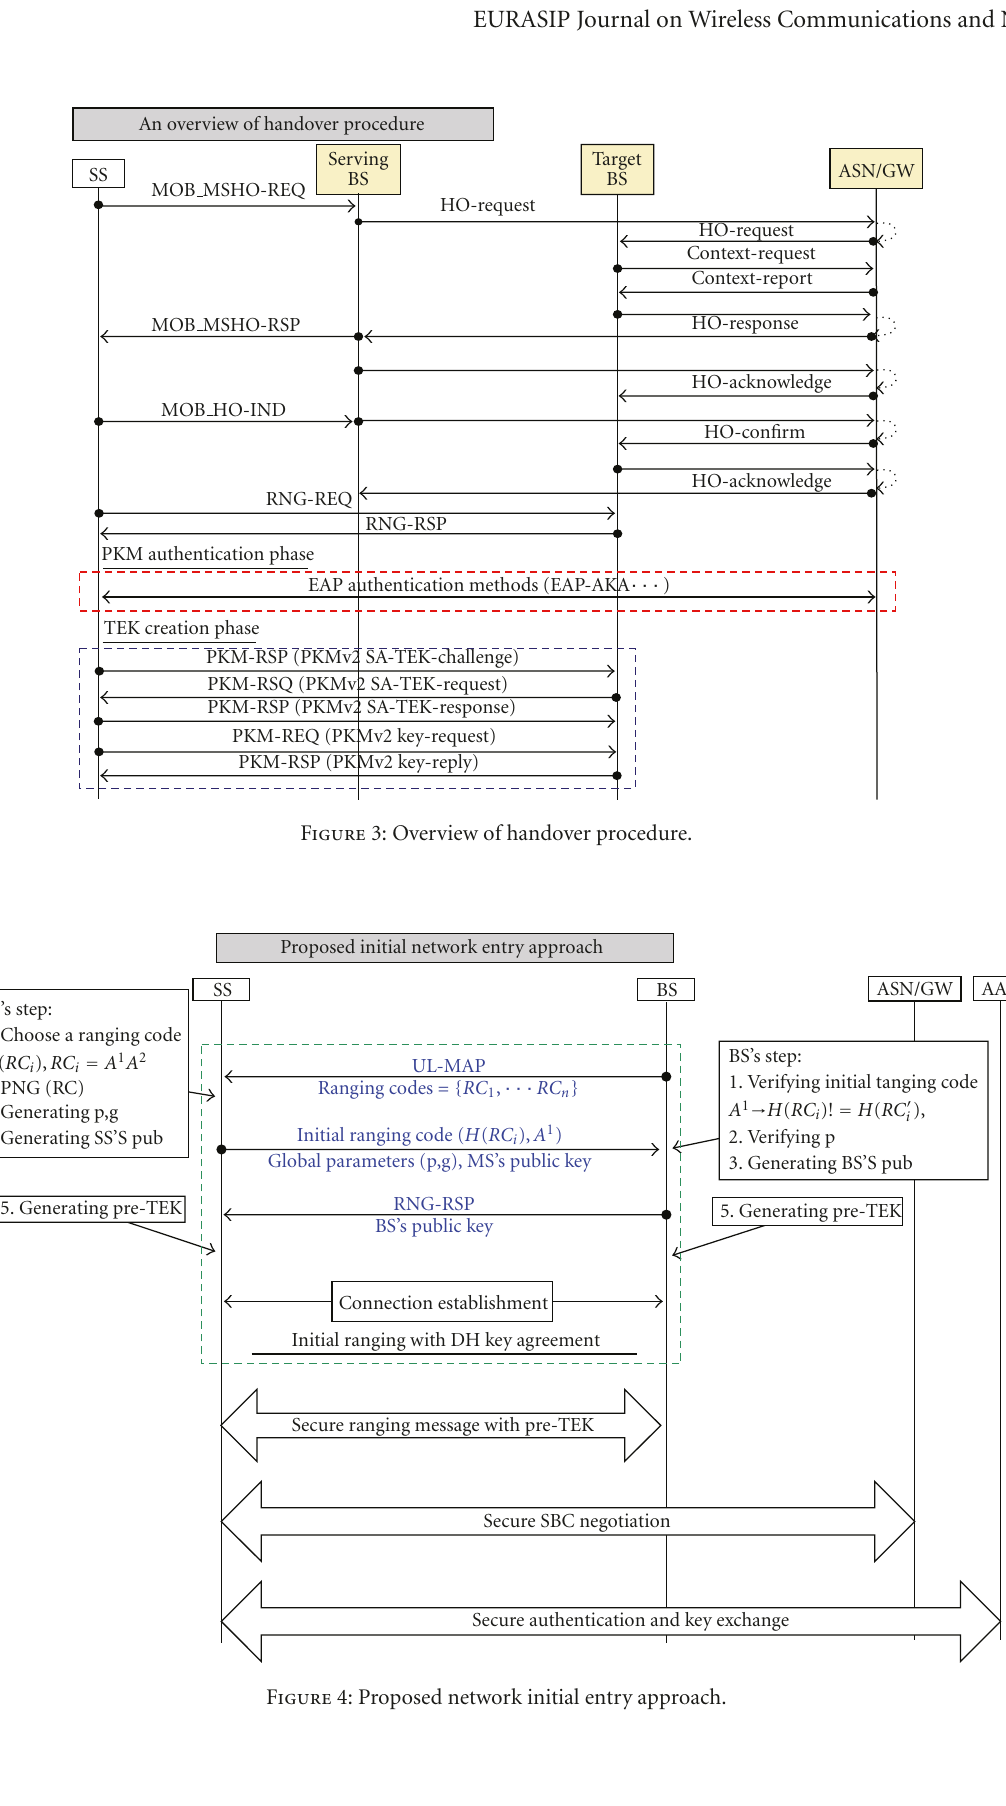
Figure 4: Proposed network initial entry